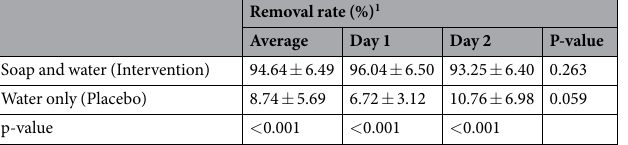
Table 2. Comparison of the removal rate of DEHP by handwashing between the intervention and placebo group in the crossover study (N = 28). [ 1 Mean ± standard